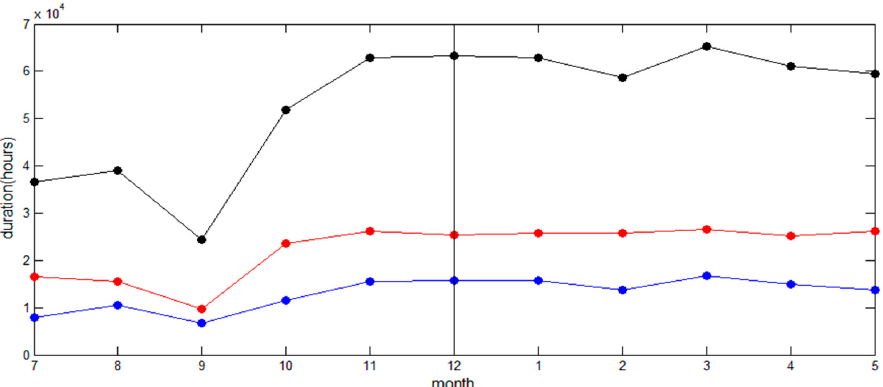
Figure 4. Time series chart of fishing effort by month: (1) The black broken line: the time invested by the vessels in all actions, including high-speed transiting and collecting nets for fishing; (2) The broken red line: the amount of fishing effort invested by the vessel transiting at high-speed to find or chase the fish; (3) The broken blue line:the amount of fishing effort invested by the vessels during low-speed purse seine operations.